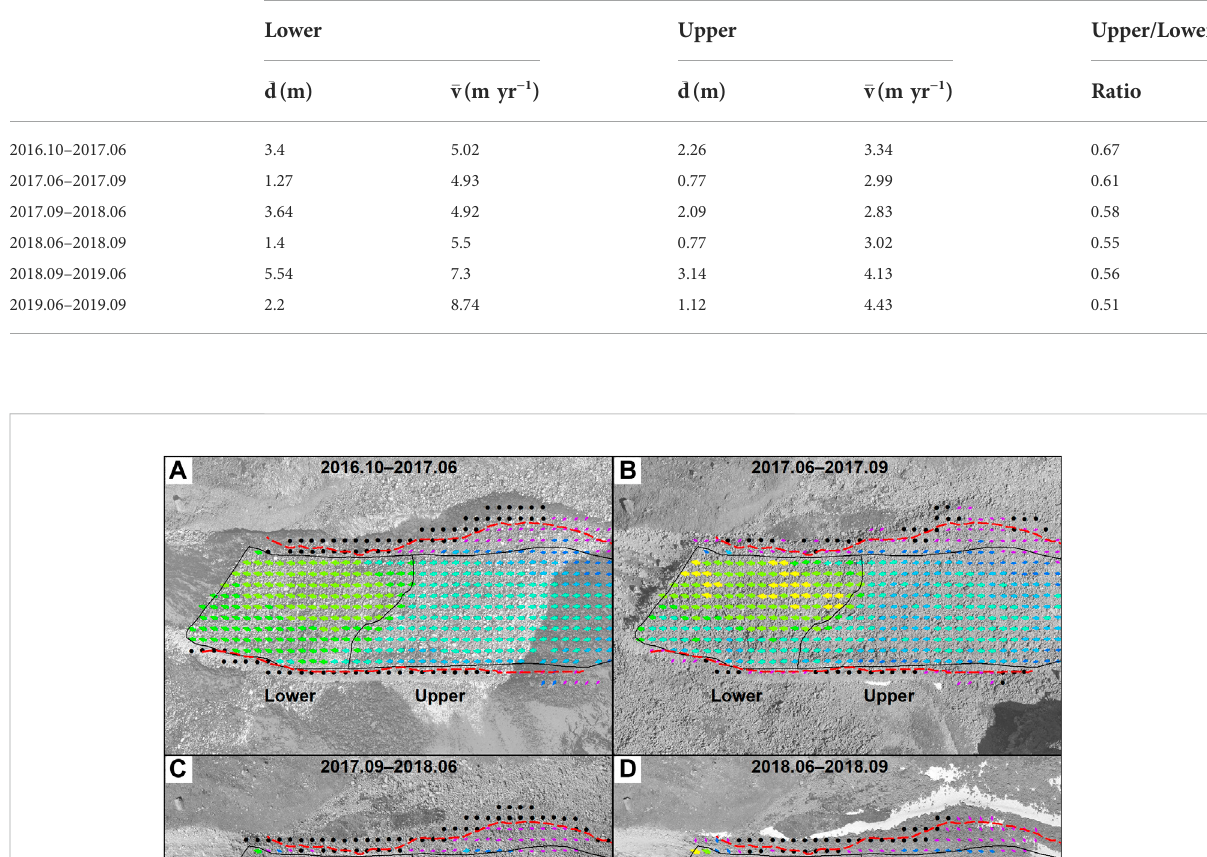
TABLE 5 UAV-derived mean horizontal displacements ( (cid:1) d) and velocities ( (cid:1) v) for the different periods on the lower and upper rock glacier sections (see Figure 4 for the locations of the sections). Periods Rock glacier kinematics zones